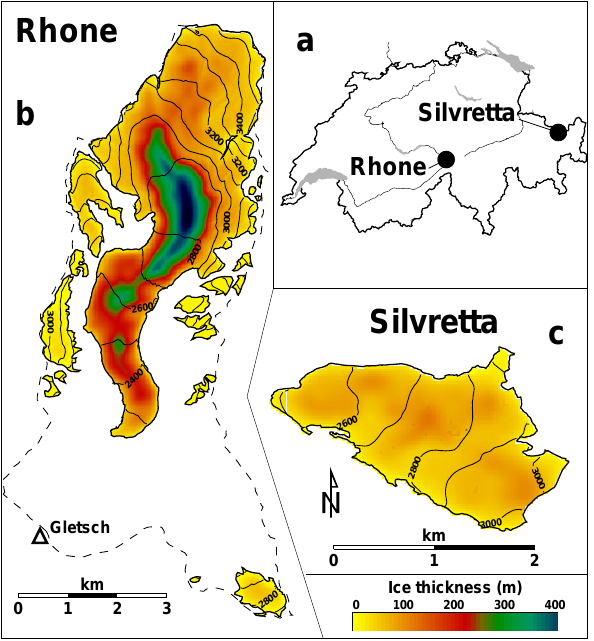
Fig. 2. Study site overview. (a) Location of the glaciers in Switzerland. (b) Hydrological drainage basin of Rhonegletscher (dashed). The gauging station at Gletsch is marked. The contour line interval is 100 m. The colours indicate ice thickness. (c) Map of Silvrettagletscher. Note that the scale differs from (b). Fig. 1. (a) Observed long-term surface elevation changes in a longitudinal glacier profile for a large alpine valley glacier (Grosser Aletschgletscher). (b) Distribution of ice thickness change along the glacier in 1957-1999. Changes in ice thickness are small in the accumulation area and largest near the glacier terminus. The variability in the equilibrium line altitude (ELA) over the 20th century is shown.